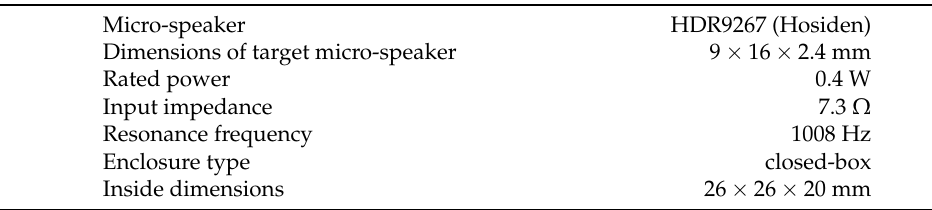
Table 1. Specifications of the target